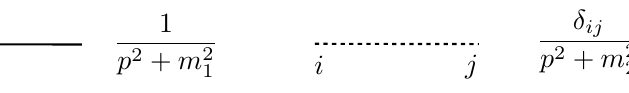
Figure 1 . The propagators for the (cid:24) and the (cid:17)